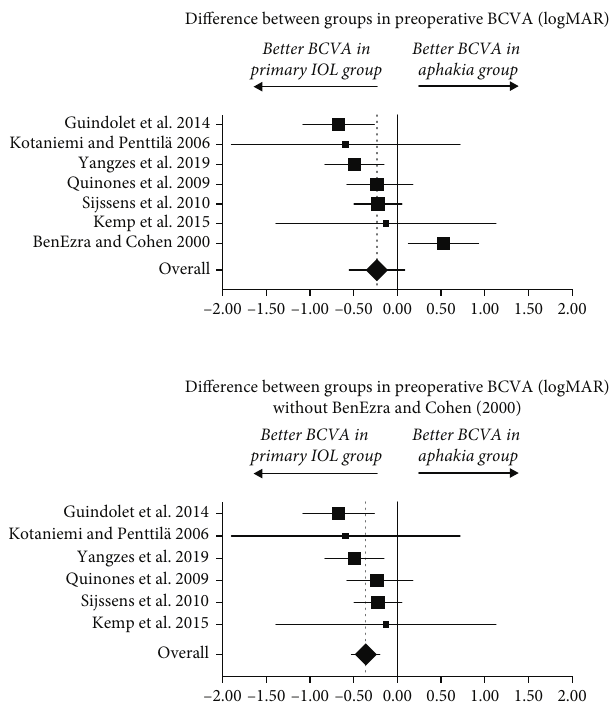
Figure 2: Forest plot of the differences between groups in the preoperative best-corrected visual acuity (BCVA). Top: Primary analysis with all eligible studies. In this analysis, BenEzra and Cohen [16] introduced a significant heterogeneity relative to the other studies. Bottom: Analyses were repeated after excluding BenEzra and Cohen [16], which significantly reduced heterogeneity. Summary estimates are weighted mean difference (WMD) in